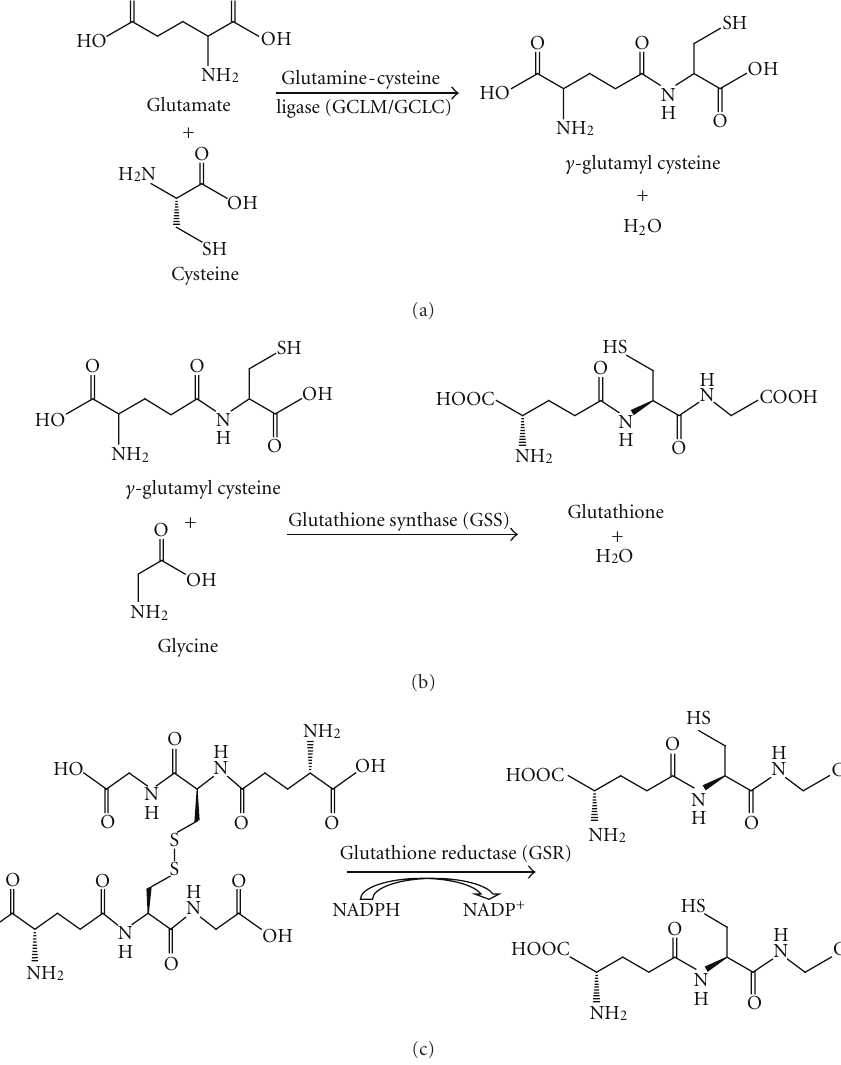
byproduct of the free radical scavenging activity of GSH and lacks antioxidant function